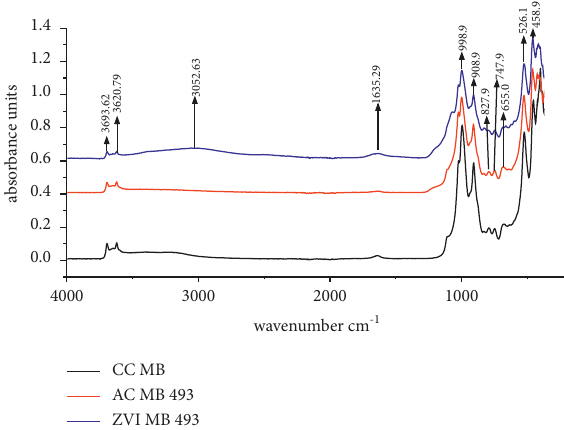
Figure 2: FTIR spectra of adsorbents crude clays CC MB acid- activated, AC MB 493, and ZVI MB 493